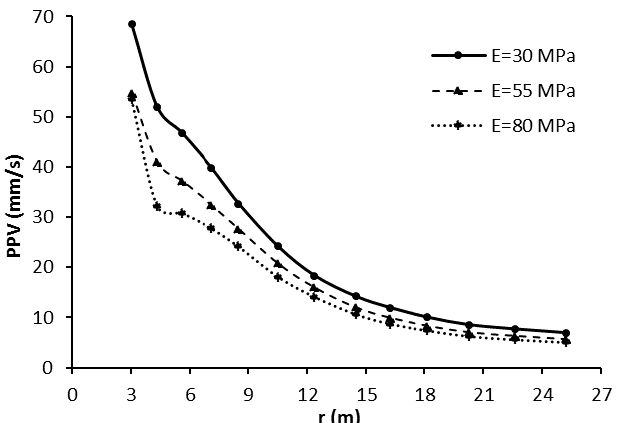
Fig. 11. Variation of PPV values on the ground surface with radial distance from pile axis for different elastic module of soil and the impact force of 3.2